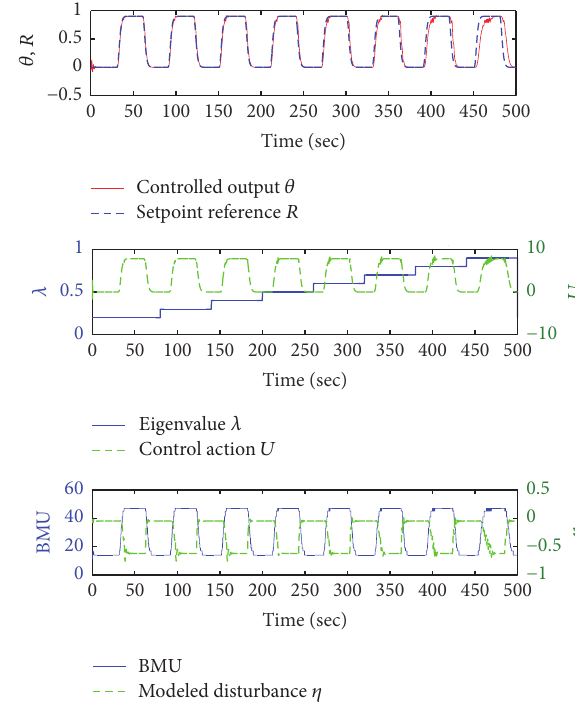
Figure 5: Results for 𝜆 prefilter = 0.4 . Figure 6: Results for 𝜆